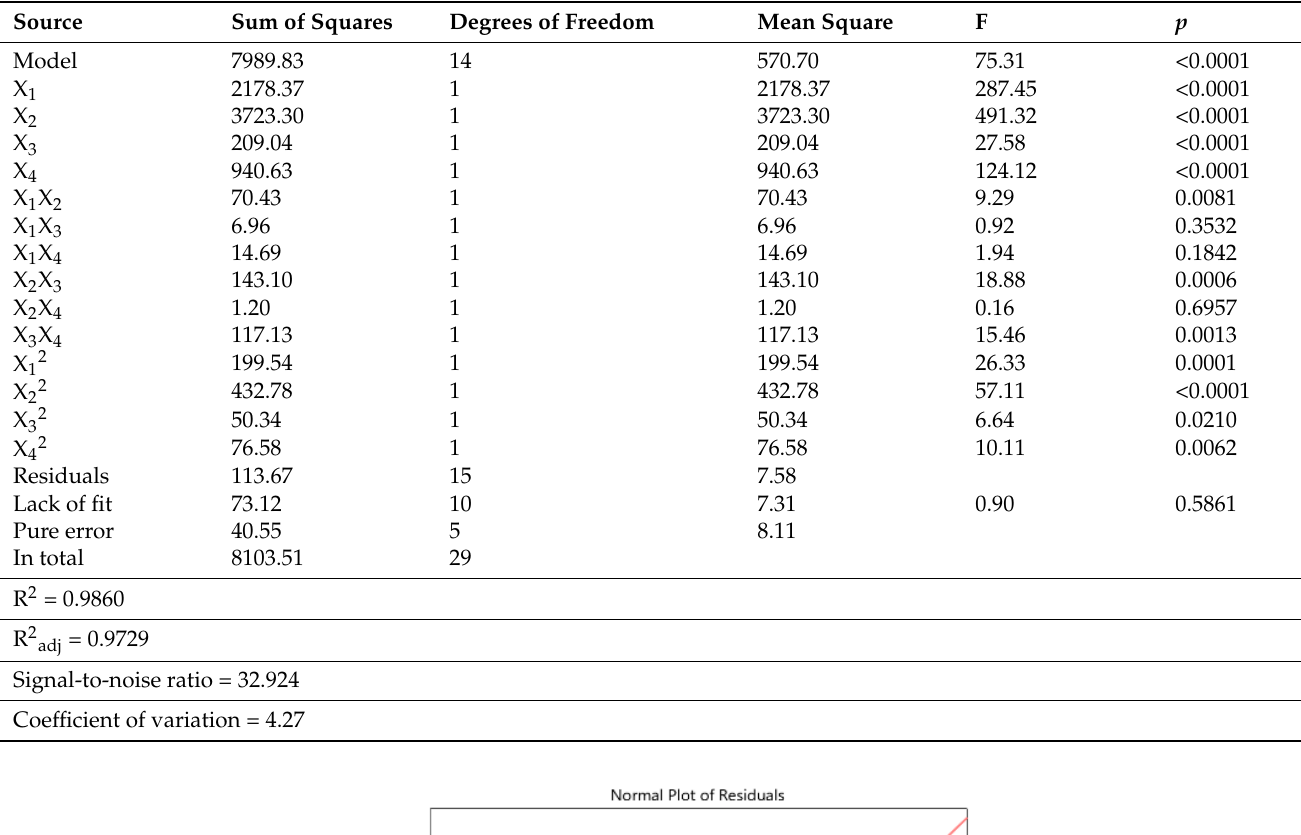
Table 3. Regression equation coefficients and significance tests.